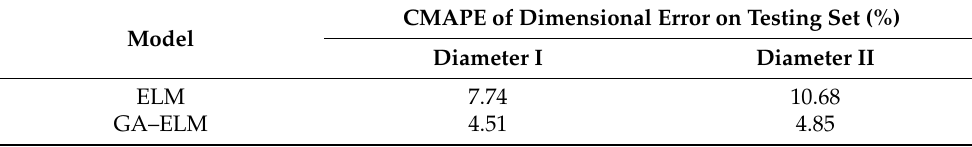
Table 4. The comparison between ELM model and GA–ELM model.